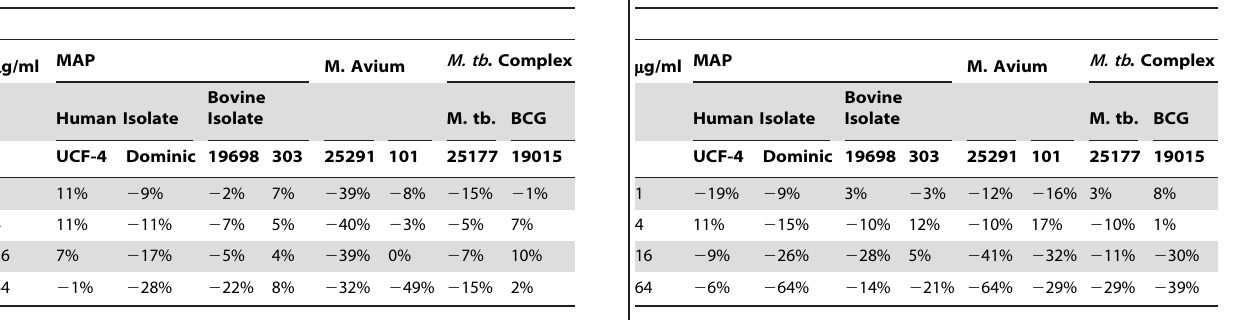
Table 2. Phthalimide Non-Inhibitory Control.